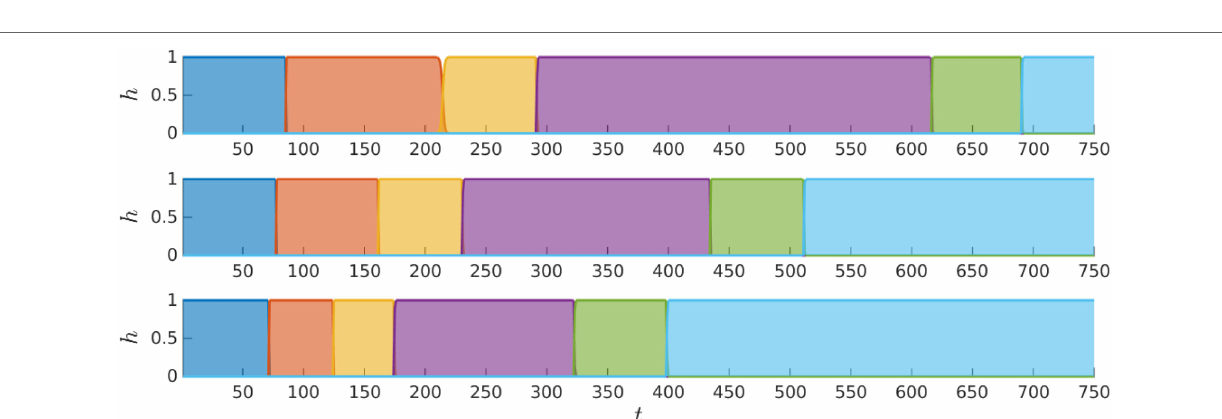
FIGURE 2 | Model, demonstrations, and reproductions of the pouring skill . (A) The 6 states model projected on the space q _ 7 , q 7 , and the demonstrations (dotted gray). Joint angles and velocities are in radian and radian per second, respectively. (B) Evolution in time of demonstrations for two different bottle weights (darker lines depict heavier bottle). (C) Reproductions of the skill, including the new situation of a half-full bottle. (D) State transition diagram and state duration probabilities (darker log-normals correspond to a heavier bottle, and therefore a longer duration).